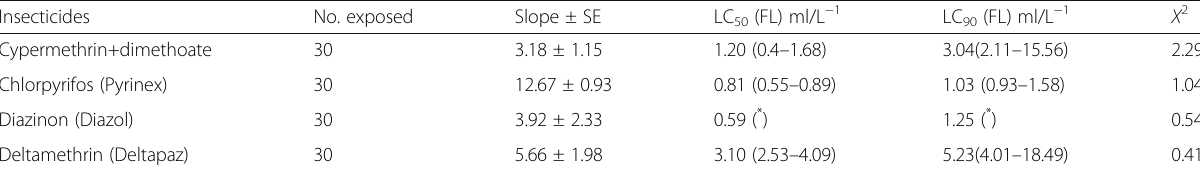
Table 1 Probit analysis of mortality of adult B. invadens to insecticides Insecticides No.